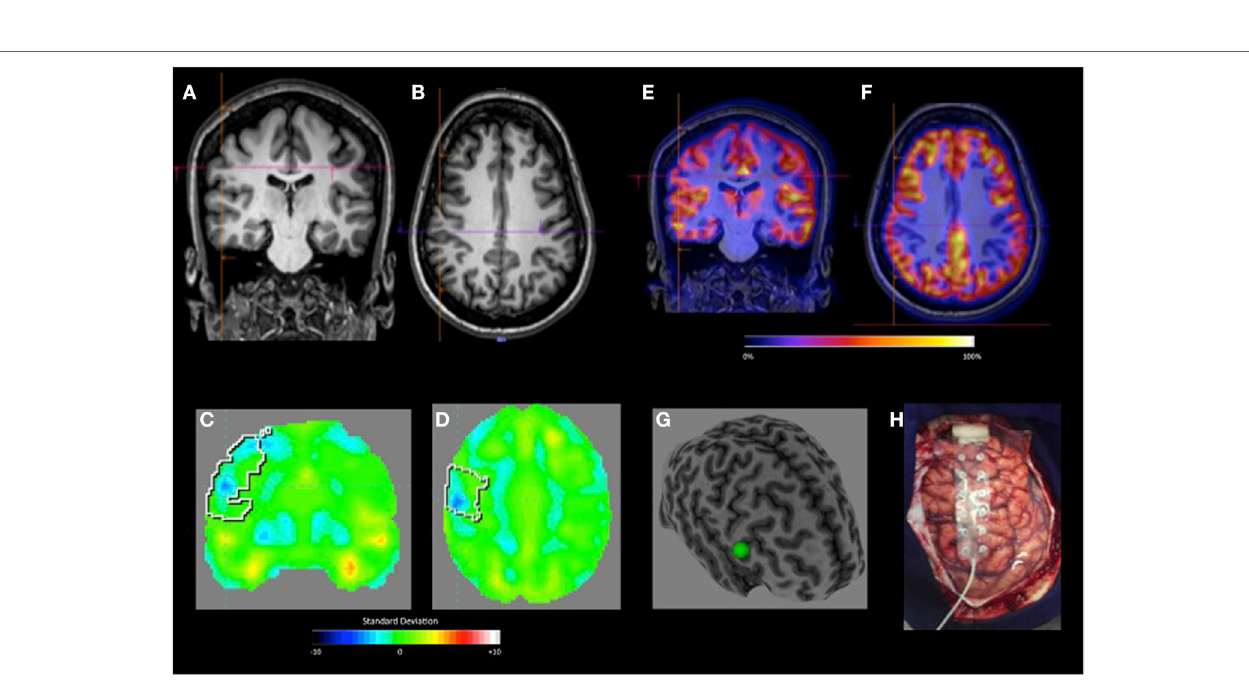
FigUre 3 | Gliosis (oligodendrogial hyperplasia). (a,B) Coronal and axial negative-MRI. The visual-positron emission tomography (PET) was initially considered normal. (c,D) Quantitative-PET showing hypometabolic area in the right central area with − 4.8 SD. (e,F) Coronal and axial PET/MRI co-registration. (g) Curvilinear reconstruction show discrete convergence of sulci and gyrus. (h) Resected brain tissue.